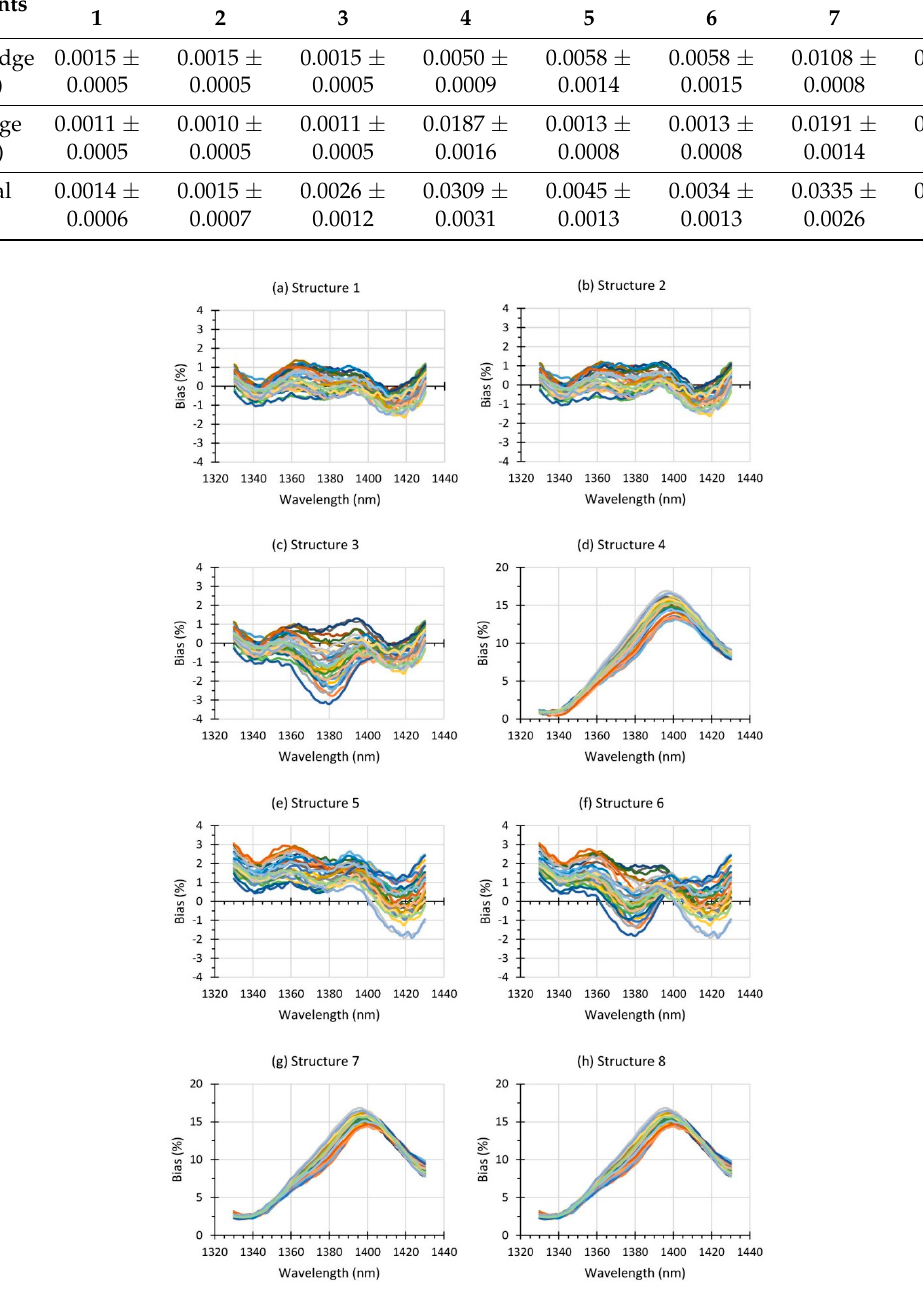
Table 3. Comparisons of the performance (mean ± standard deviation of the root mean square error (RMSE)) of the GLGCM technique with a variety of parameter sources using the laboratory based data.